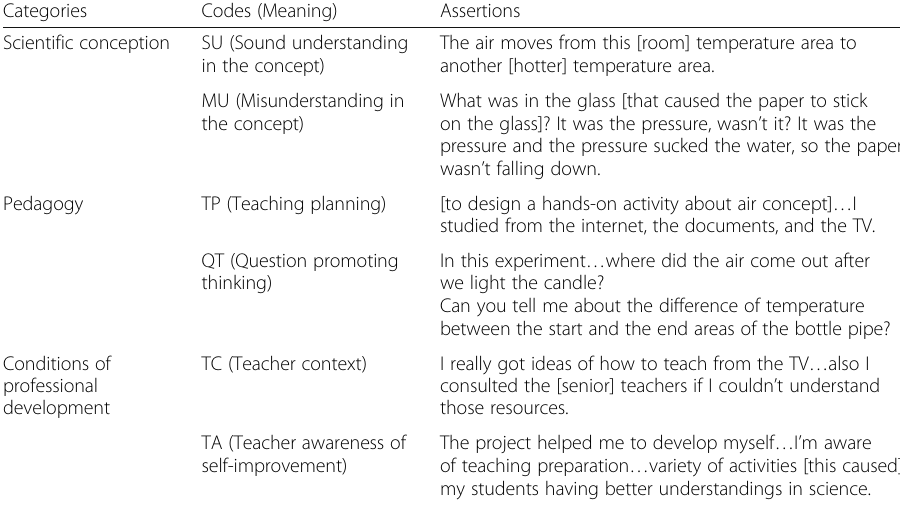
Table 1 Examples of categories, codes, and assertions